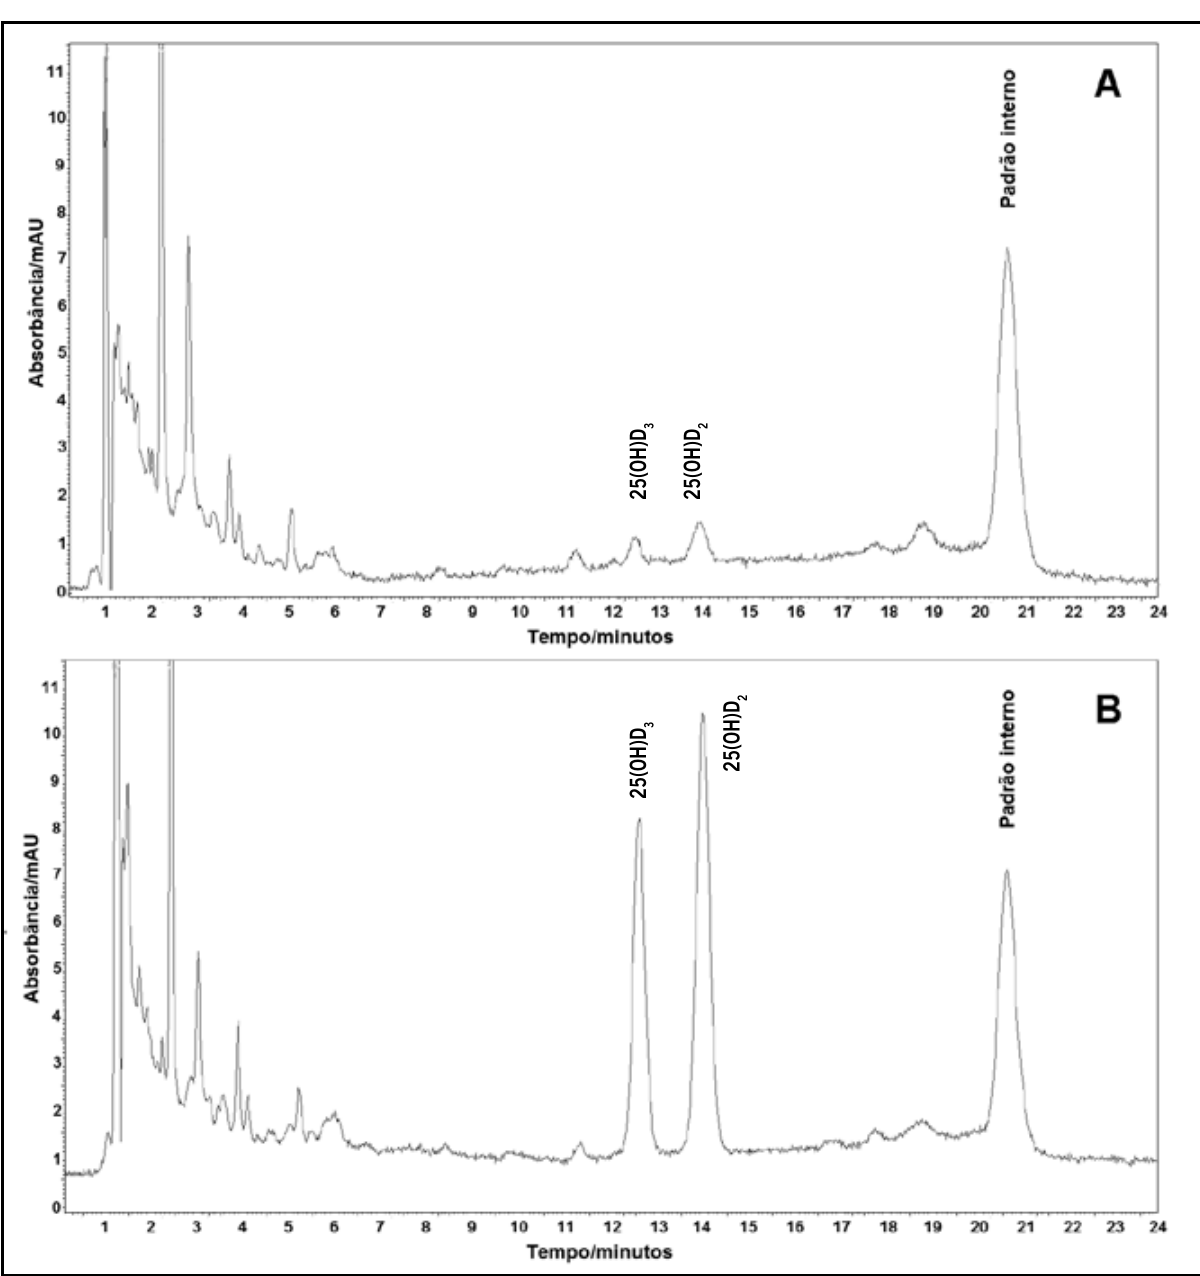
Figura – Cromatogramas obtidos com o método. (A) amostra controle contendo 25(OH)D 25(OH)D na concentração de 200 2